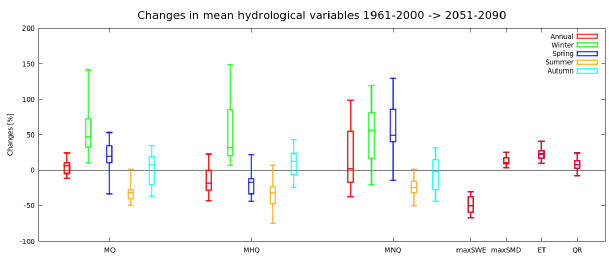
Figure 15. The minimum, maximum, 1st and 3rd quartile and me- dian changes by 2051–2090 period in mean discharges (MQ), mean high discharges (MHQ), mean low discharges (MNQ), mean maxi- mum snow water equivalent (maxSWE), mean maximum soil mois- ture deficit (maxSMD), mean annual evapotranspiration (ET) and runoff ( R ) in four test catchments and five scenarios with Gaussian and double gamma-adjusted RCM